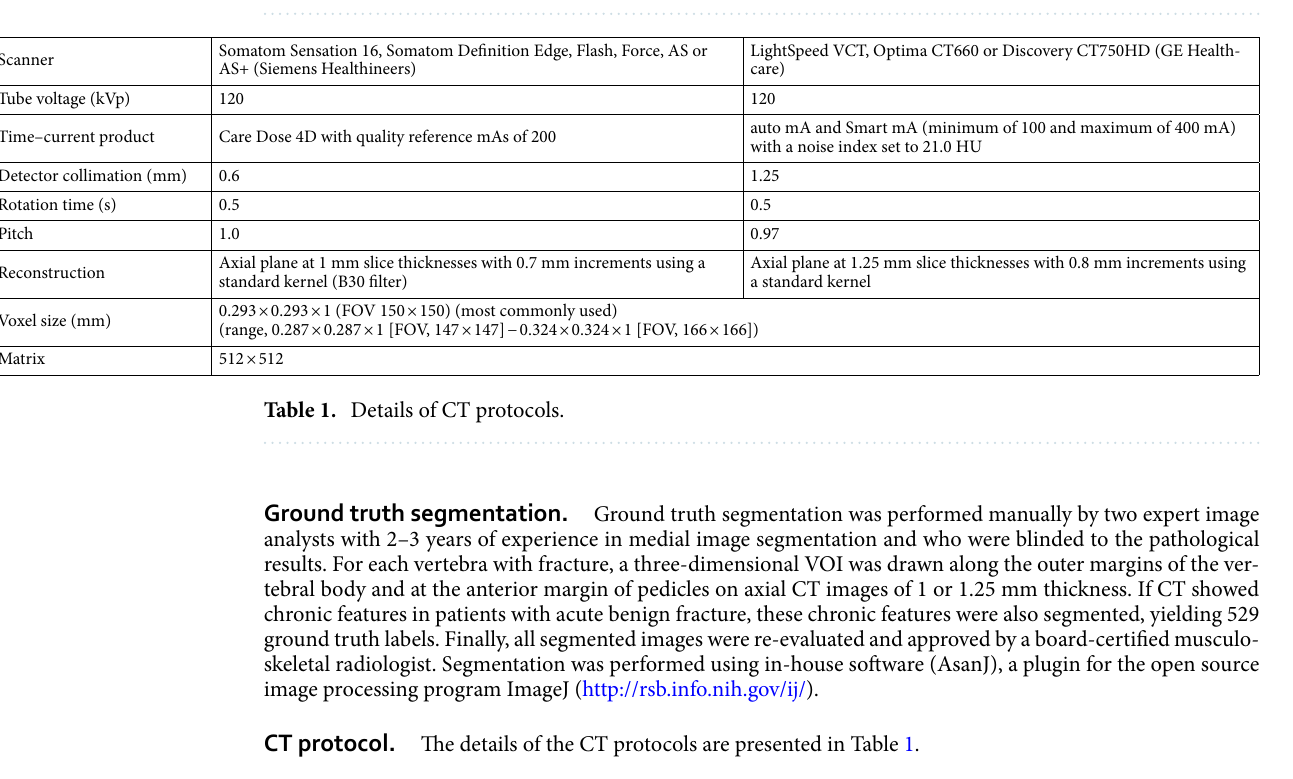
Figure 1. Flow diagram of the study.